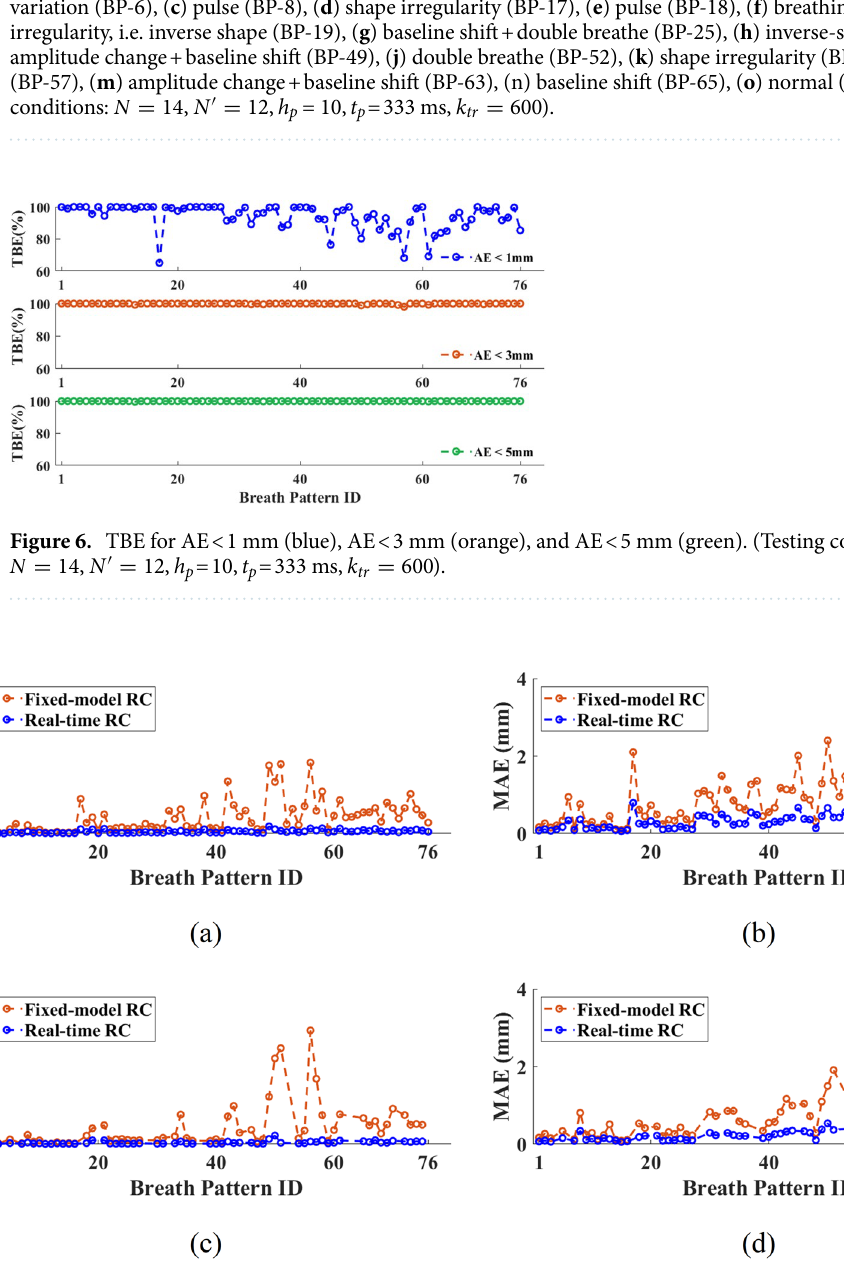
Figure 5. RC motion prediction results for BPM 1–10 ( a – d ), BPM 10–15 ( e – j ), BPM 15–20 ( k – o ). The first 20 s of the motion signals are included in the breathing pattern graphs while the first predicted motion signal occurs at t = t p + 20 s. In the position versus time graph, the predictive values at t p = 66.6 ms (blue), 166.6 ms (cyan), and 333.3 ms (brown) are plotted with the ground truth (black) for comparison. Corresponding NMSE and MAE for each motion curve prediction are listed on top of each graph. In the AE vs time graph, the absolute error are plotted with three criteria dash lines of AE = 1 mm (red), 3 mm (brown), 5 mm (black). The irregularities of the breath patterns are summarized here: ( a ) normal (BP-3 ), ( b ) amplitude and frequency variation (BP-6), ( c ) pulse (BP-8), ( d ) shape irregularity (BP-17), ( e ) pulse (BP-18), ( f ) breathing pattern shape irregularity, i.e. inverse shape (BP-19), ( g ) baseline shift + double breathe (BP-25), ( h ) inverse-shape (BP-26), ( i ) amplitude change + baseline shift (BP-49), ( j ) double breathe (BP-52), ( k ) shape irregularity (BP-53), ( l ) pulse (BP-57), ( m ) amplitude change + baseline shift (BP-63), (n) baseline shift (BP-65), ( o ) normal (BP-66). (Testing